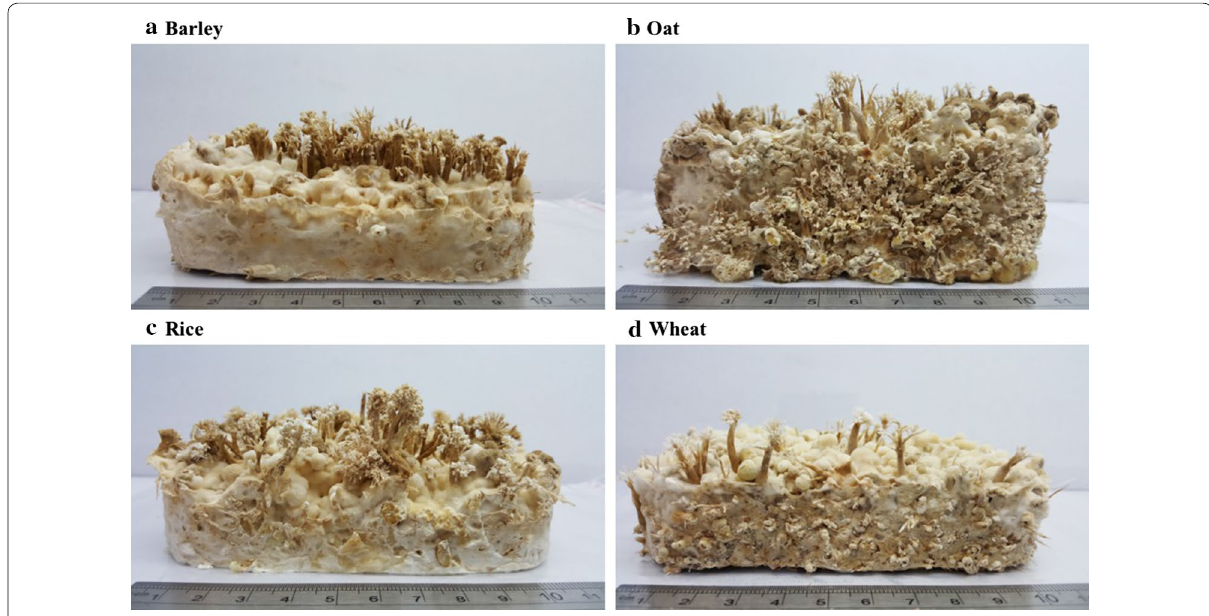
Fig. 1 Fruit bodies of C. cicadae NTTU 868 fermented with different grain substrates a barley; b oat; c rice; d wheat